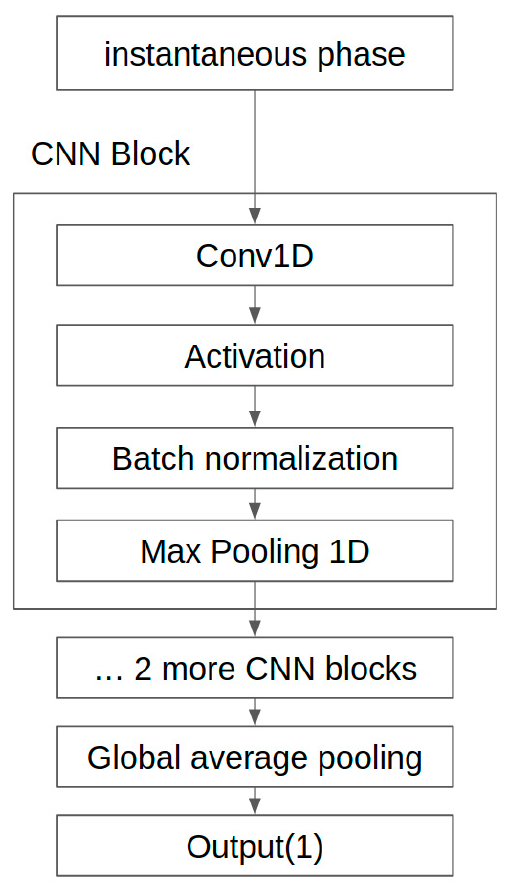
Figure 4. The architecture of the convolutional neural network (CNN) model.